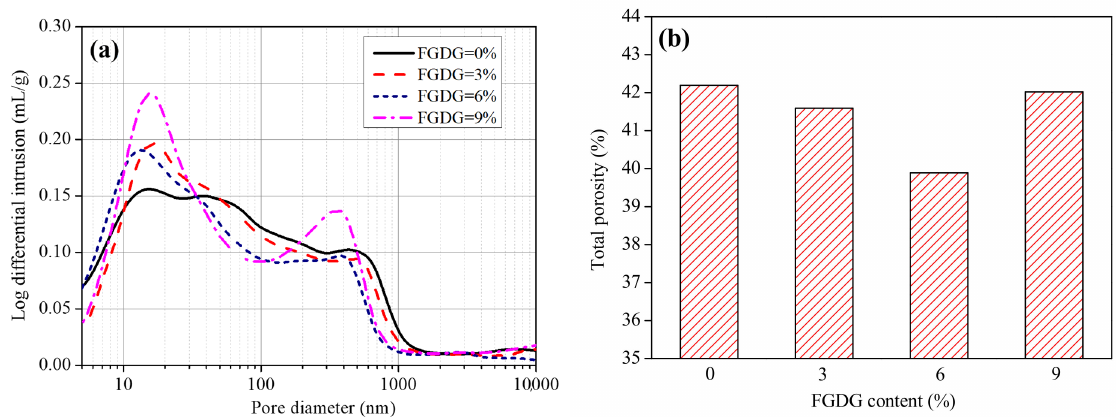
Figure 5. Pore structure of CSAC-GGBFS mixtures blended with different FGDG content hydrated for 120 d. ( a ) Pore size distribution, ( b ) total